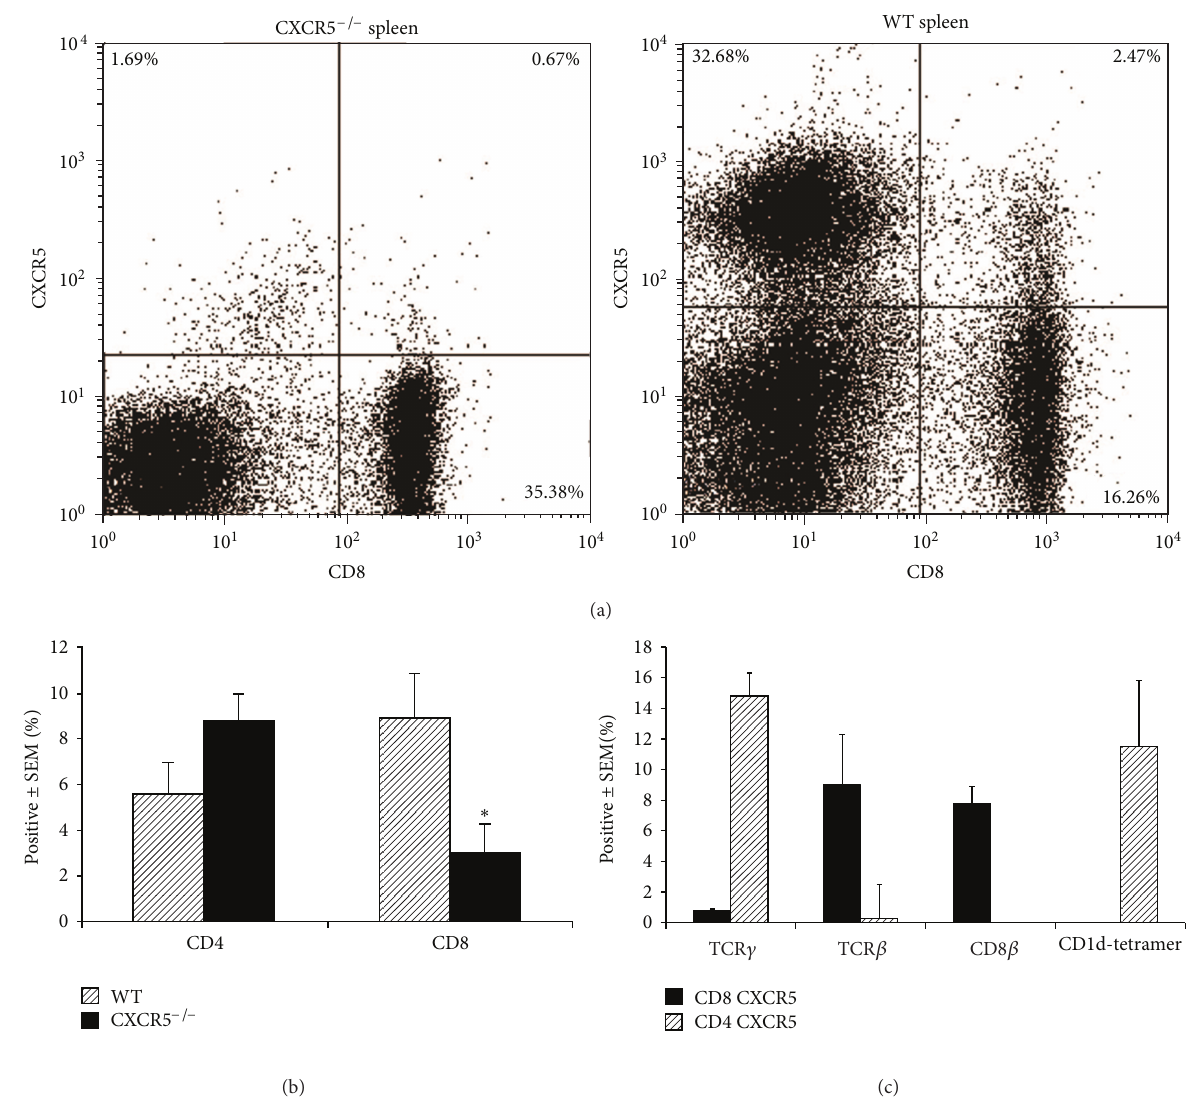
CXCR5 cells. Spleen cells were isolated from C57BL/6 WT mice 7 days aer genital infection with C. or NKT cells; CD1d-tetramer. (a) e + cells from and WT mice. (b) e percent of CD4 or CD8 populations 𝛾𝛾𝛾𝛾 𝛽𝛽 indicates . (c) e percentage + −/− 𝐶𝐶𝐶𝐶𝐶𝐶𝐶𝐶𝐶 ∗ 𝑃𝑃 𝑃 𝑃𝑃𝑃𝑃